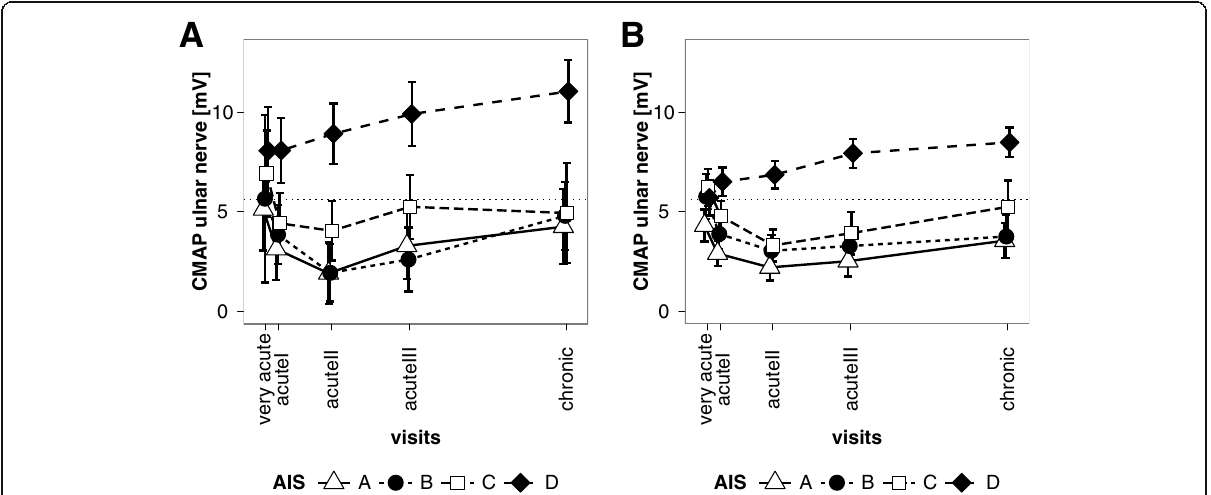
Fig. 2 a Mixed model estimates of means and 95% confidence intervals of right ulnar CMAP amplitudes in the EMSCI-HD cohort over the 1-year follow up. b Mixed model estimates of means and 95% confidence intervals of right ulnar CMAP amplitudes in the EMSCI-nonHD cohort over the 1-year follow